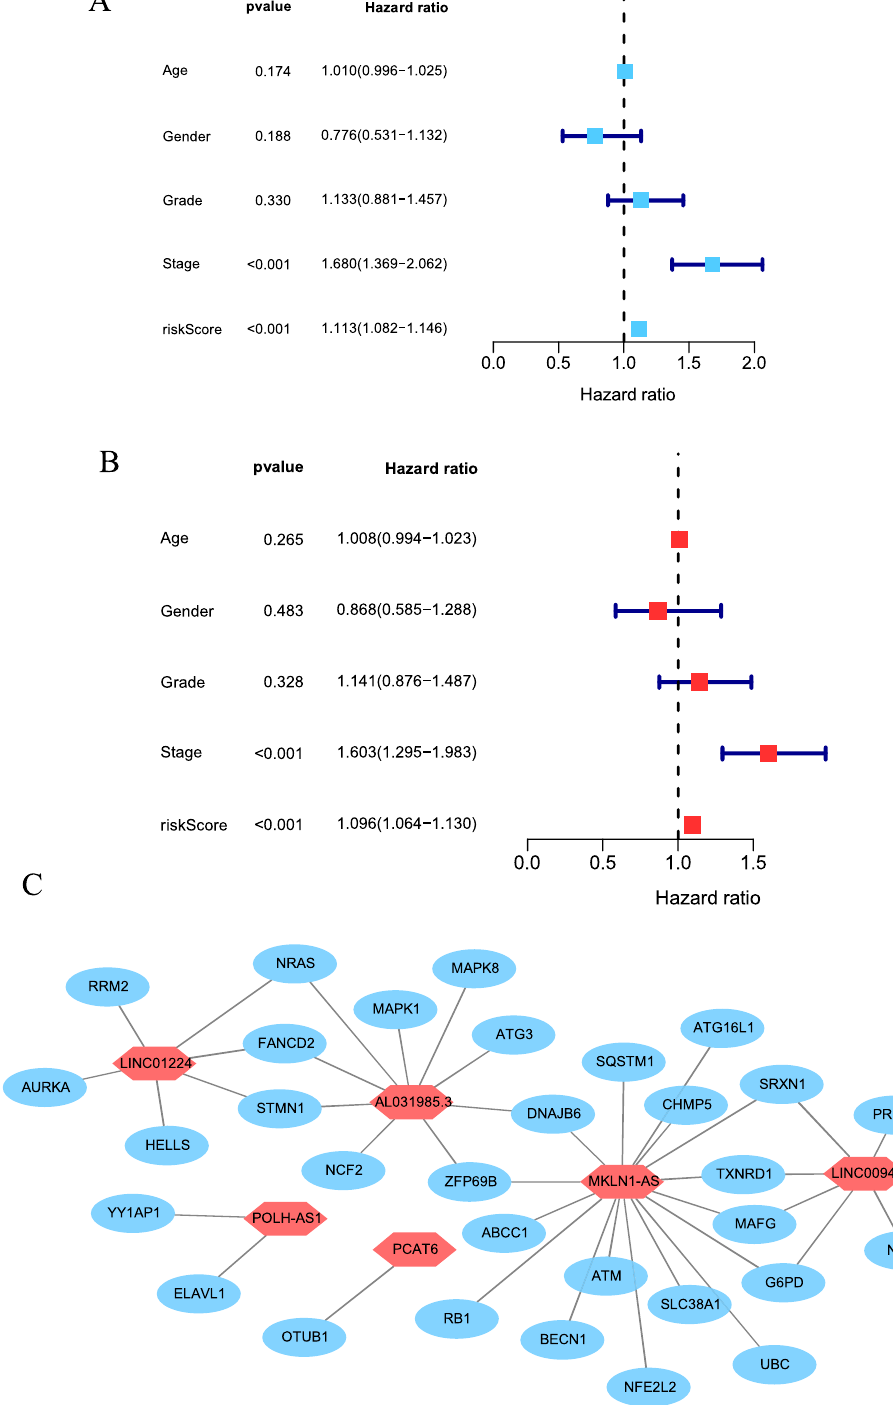
Figure 5. Assessment of the prognostic signature of the ferroptosis-related lncRNAs. ( A ) Univariate Cox regression analysis of the clinical characteristics and riskScore with the OS. ( B ) Multivariate analysis of the clinical characteristics and riskScore with the OS. ( C ) The relationship between the novel lncRNA and mRNA